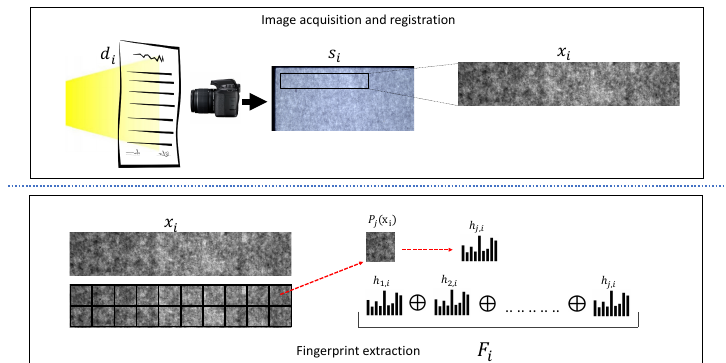
Figure 1. Overall pipeline of the proposed framework. First row describes the process to acquire documents; second row shows the fingerprint extraction